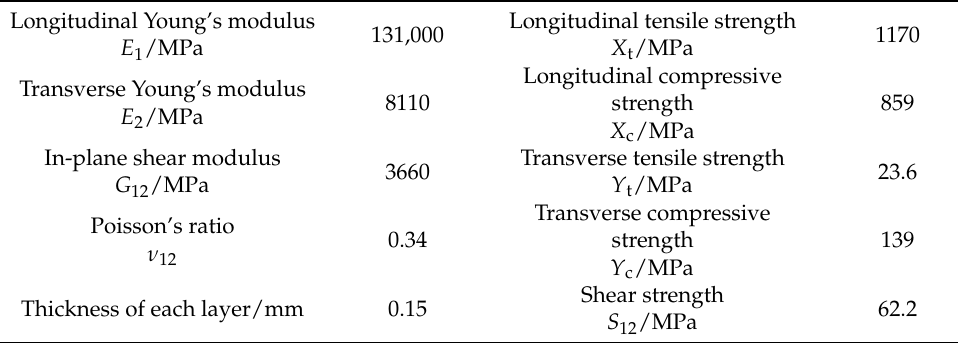
Figure 4. Two-dimensional finite element model of the bolted joint.